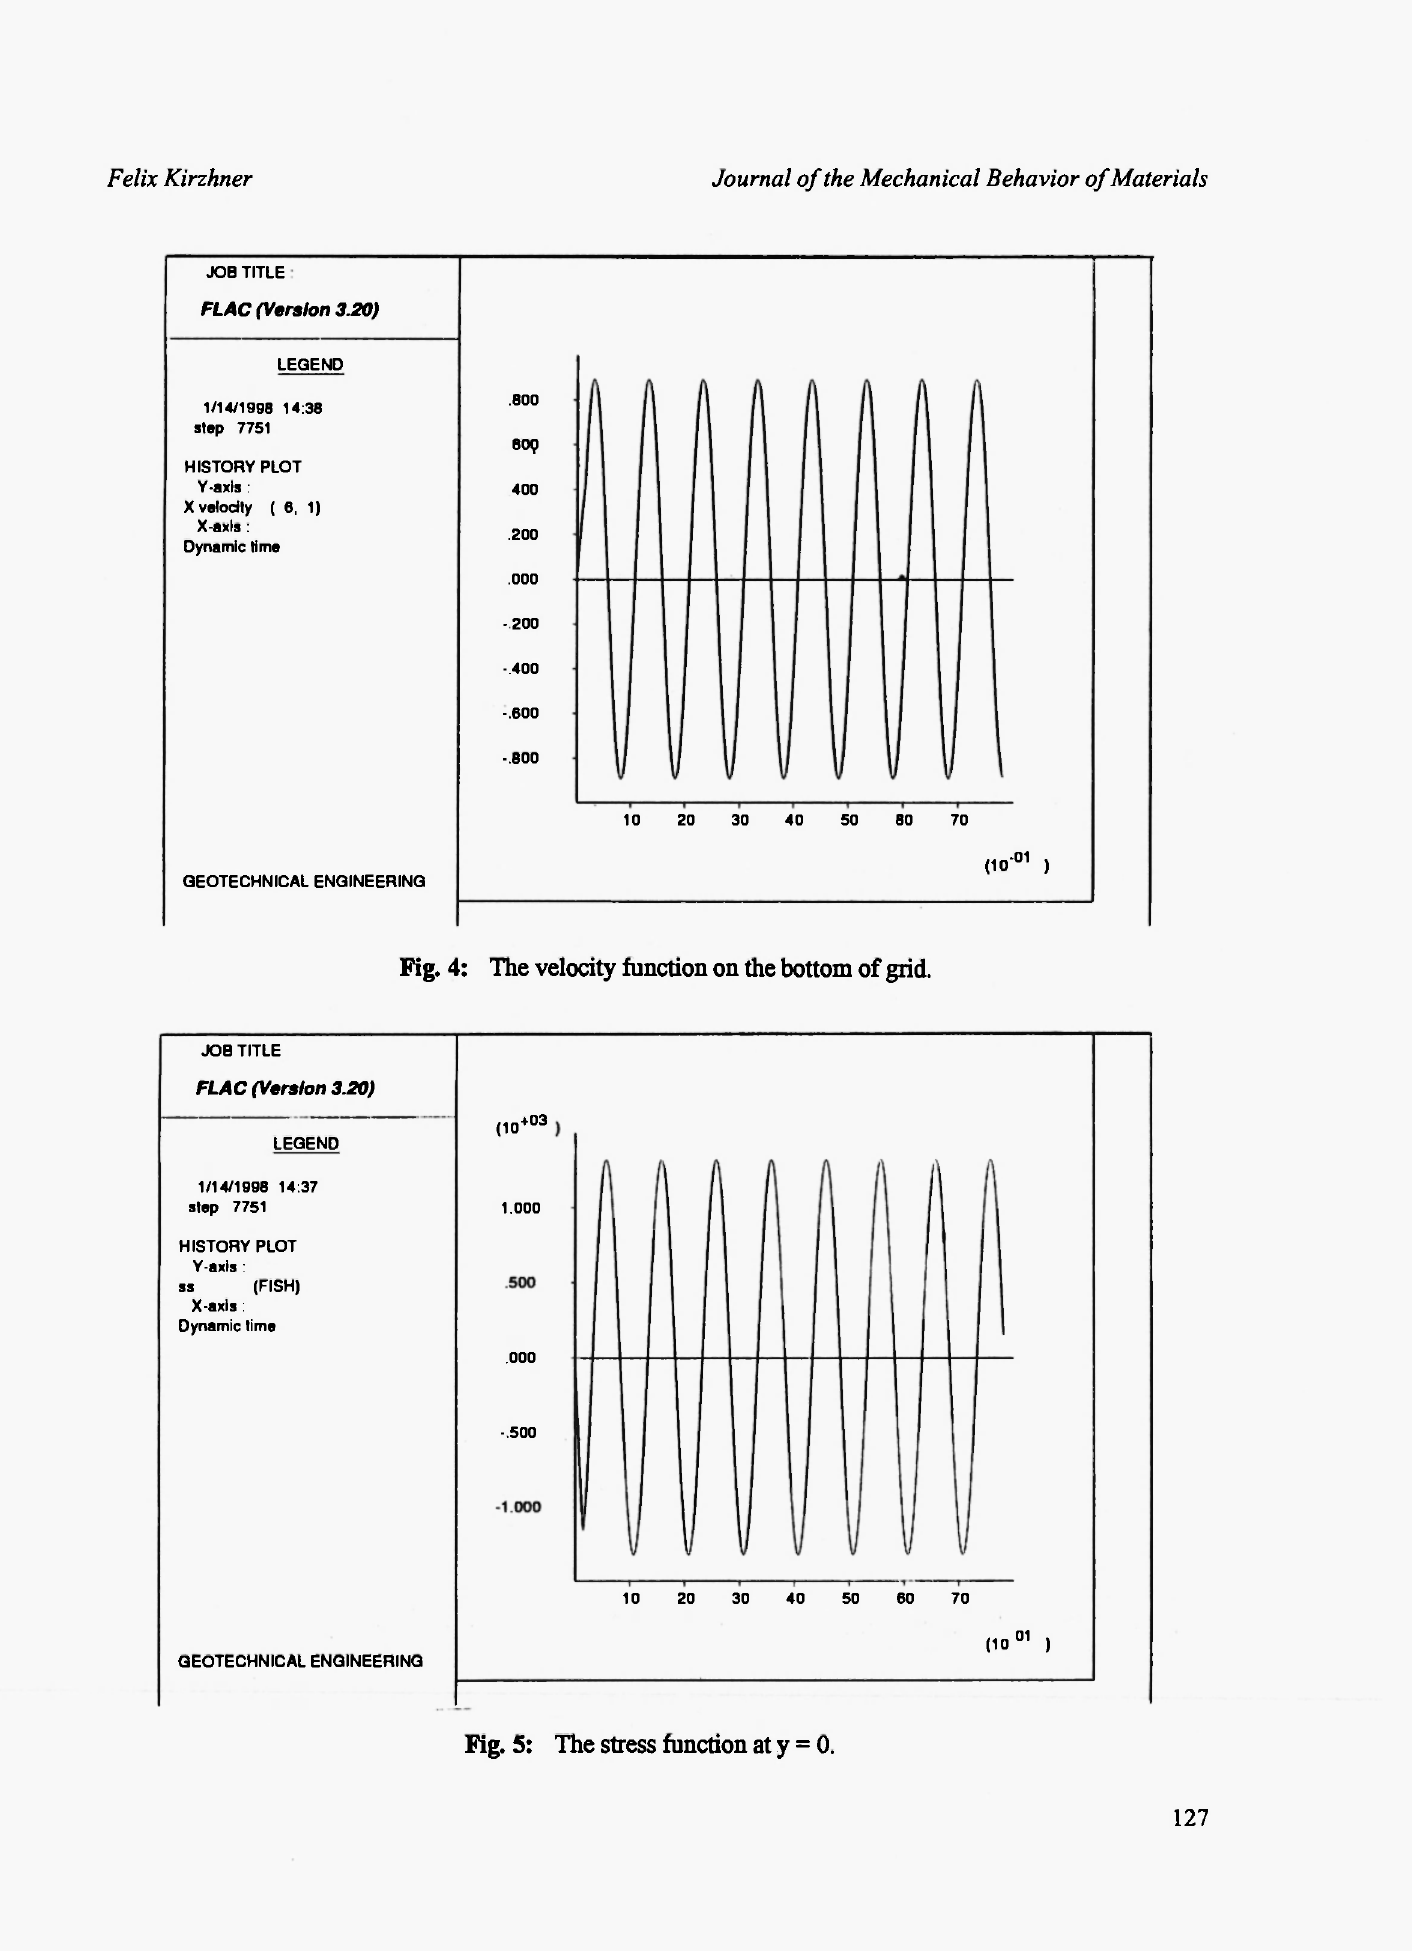
Fig. 5: The stress function at y =